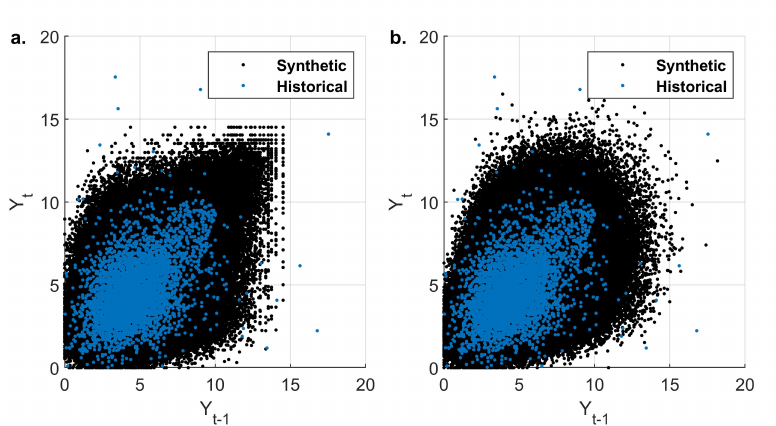
Figure 8. Scatter plot comparison of generated Evaporation { Y t } auto-dependence structures with